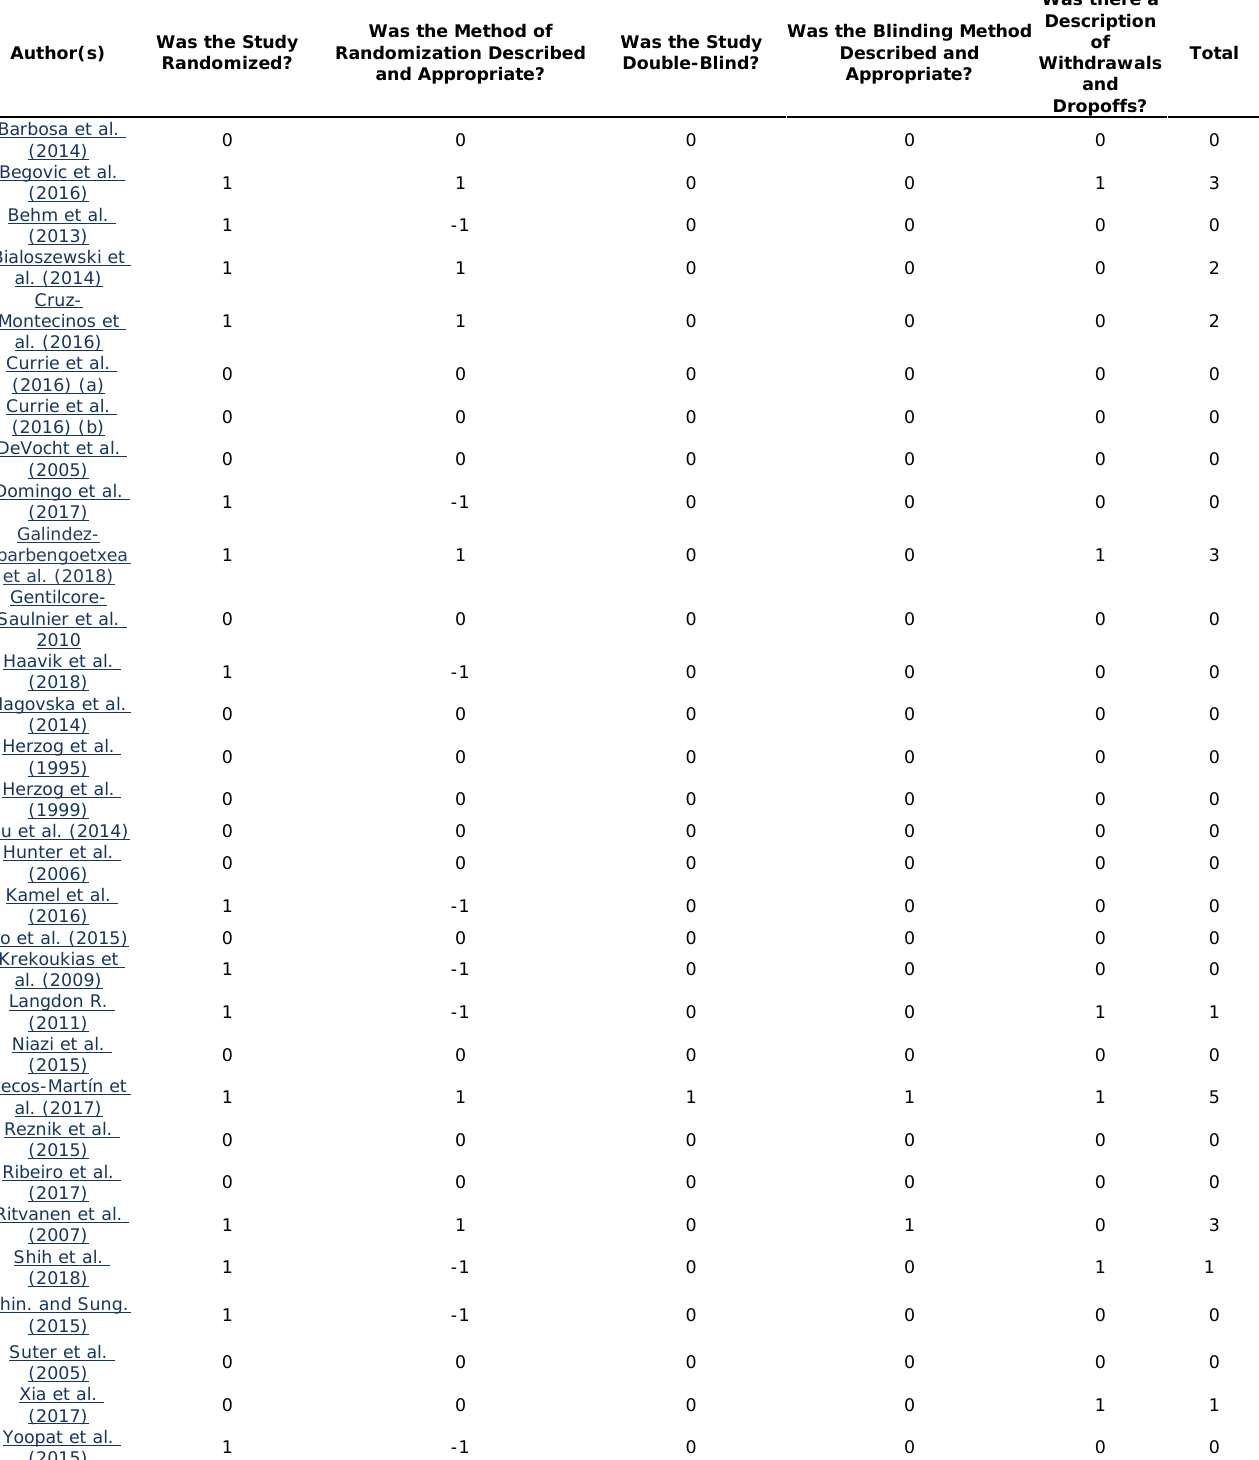
Table 4. Risk of bias in the clinical trial studies, using the Jadad